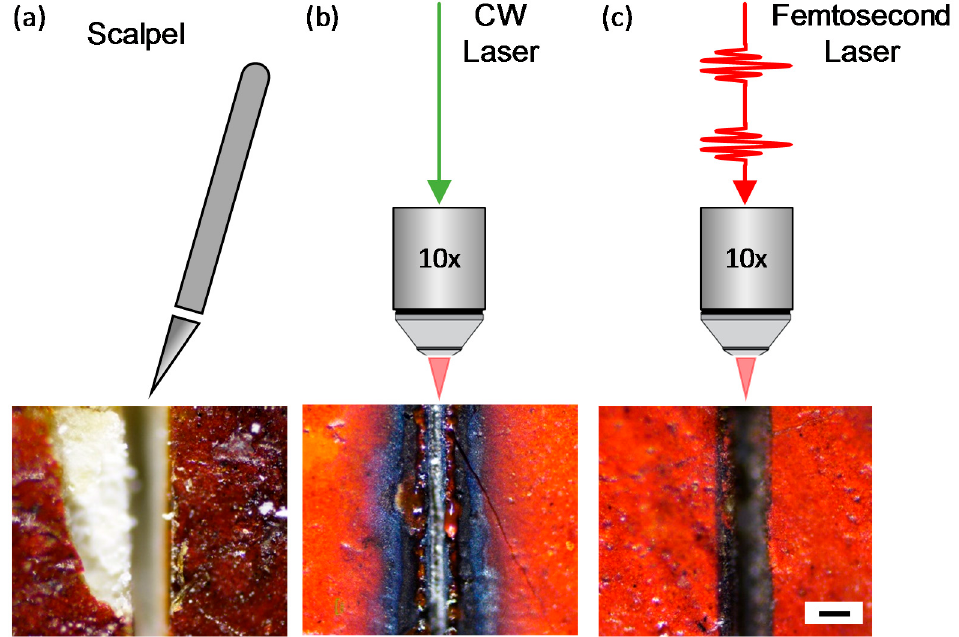
Figure 2. Schematic illustrations and optical images of the paint sample 1 which was cut by a ( a ) scalpel; ( b ) 60-mW CW laser; and ( c ) 2-mW (0.64-J/cm 2 ) femtosecond laser. The laser beams were focused onto the sample through a 10× objective lens. The black scale bar is 100 μ m.